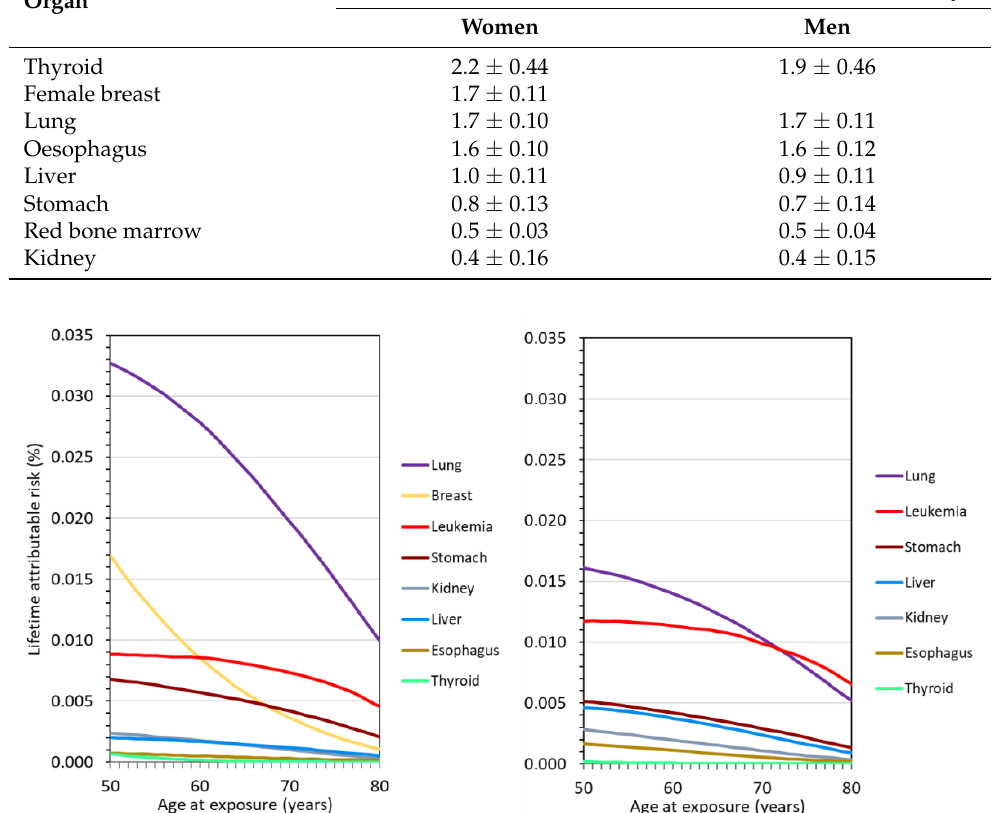
Table 2. Representative organ-specific dose coefficients for a female or male reference person. Only those organs were considered that are located — at least in part — in the radiation field and contribute to the LAR .